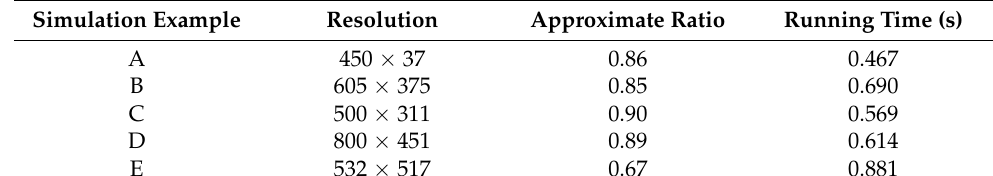
Table 1. Data results from the flange image set run.